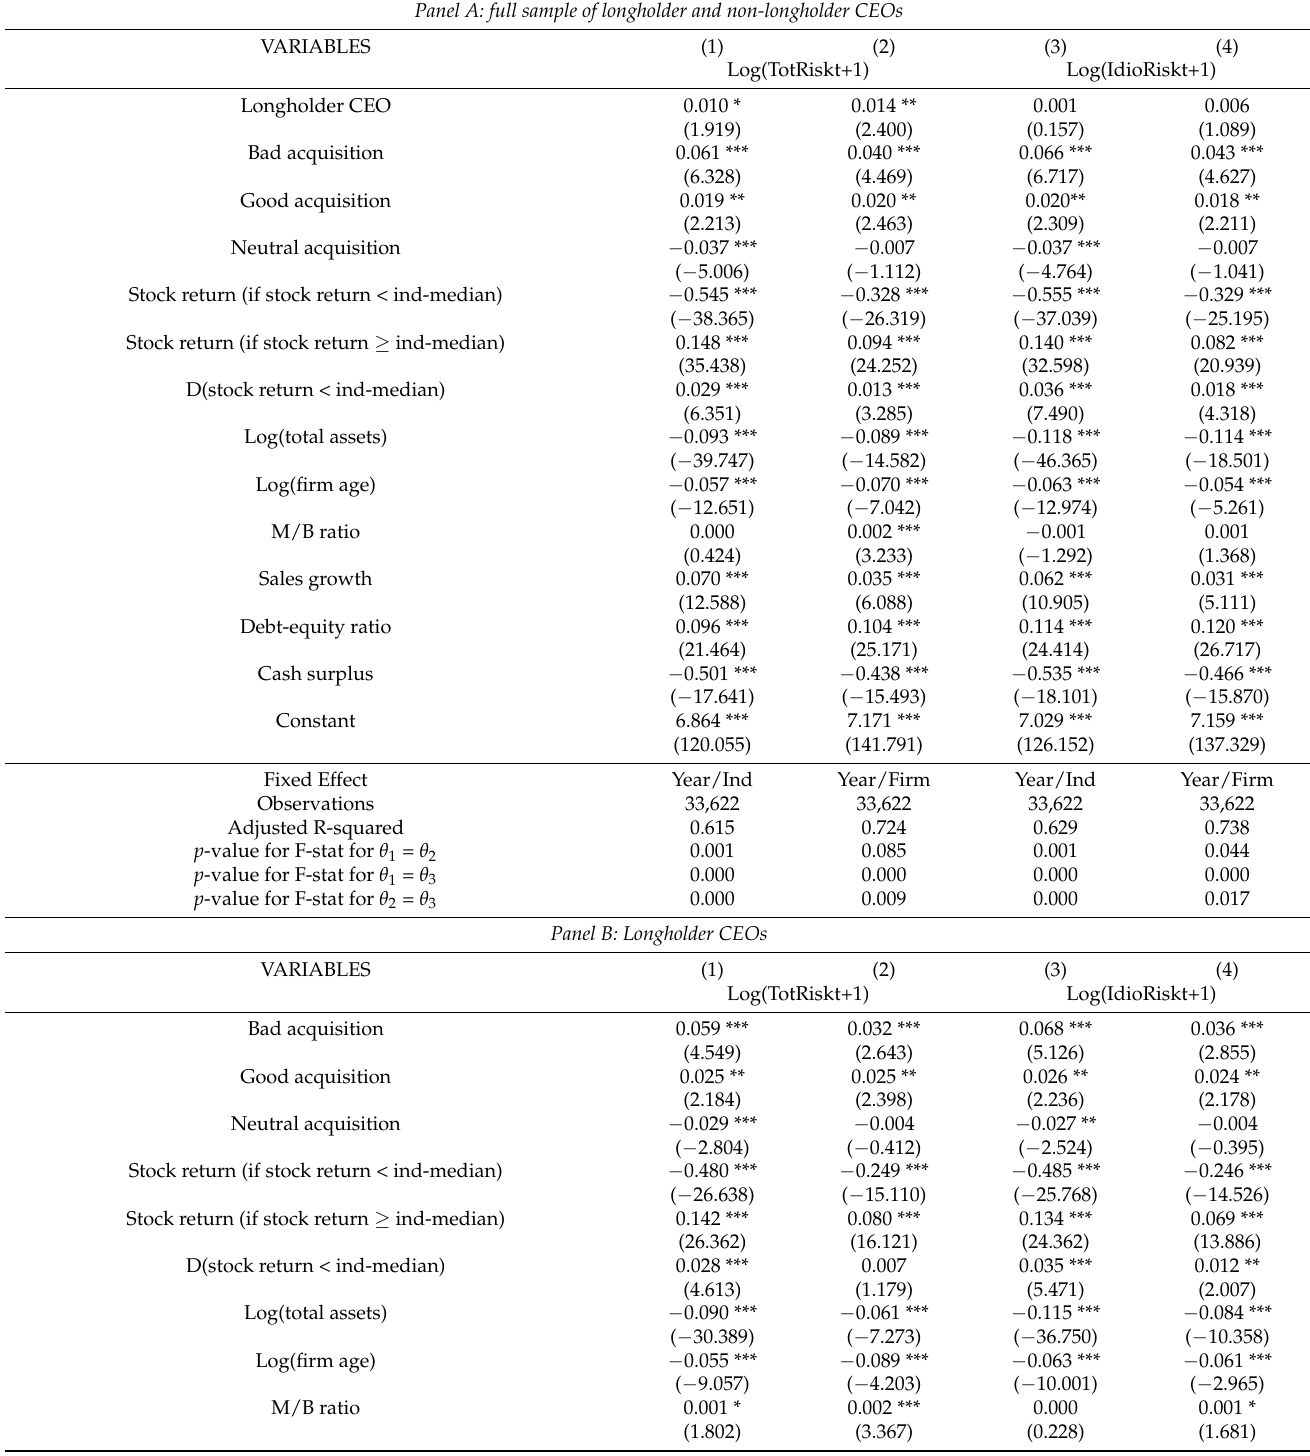
Table 8. Firms with longholder CEOS. This table presents the OLS regression results for the sample of firm-year observations between 1990 and 2015. Variable definitions are in the Appendix A. All regressions control for fiscal-year fixed effects and industry/firm fixed effects whose coefficients are suppressed for brevity. t-statistics based on standard errors adjusted for heteroskedasticity (White 1980) and firm clustering are reported in parentheses. *, **, and *** denote statistical significance at the 10%, 5%, and 1% levels,